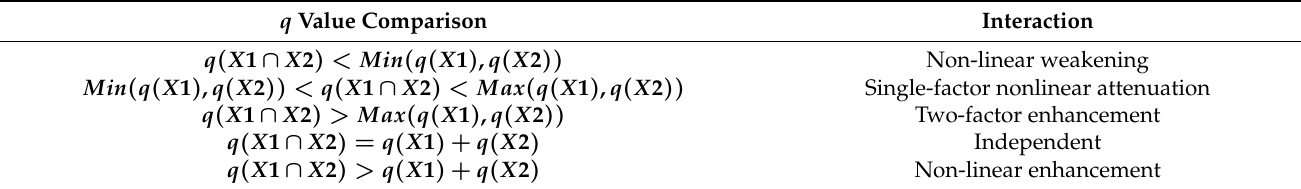
Table 1. Interaction detector types.